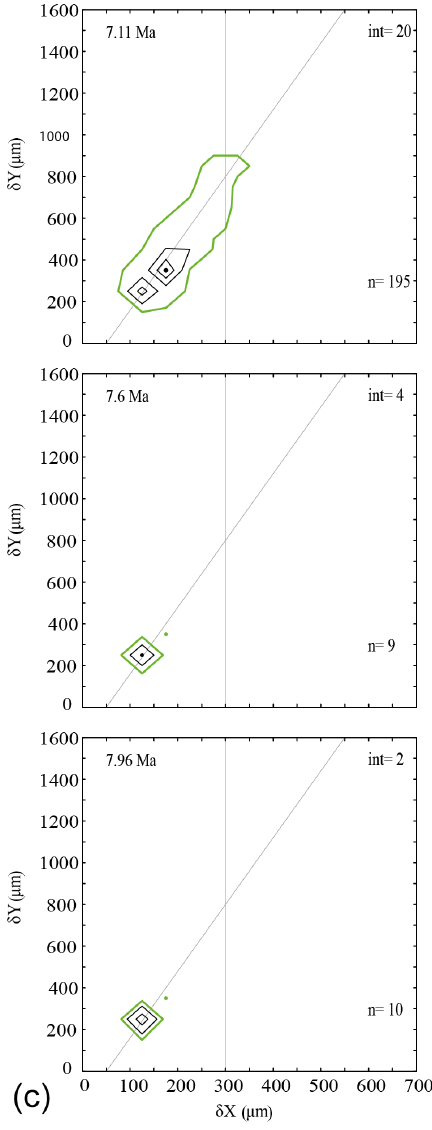
Figure 8. (a, b, c) Contoured frequency plots of spiral height ( δX ) on the x axis versus the axial length ( δY ) on the y axis of Globoro- talia menardii in keel view at ODP 108 Site 667 from 0.003 to 7.96Ma. The upper-left corner shows the age (Ma). “int” indicates the contour interval in the number of specimens per grid cell. The grid-cell size is 50µm × 100µm in direction of δX and δY , re- spectively. “ n ” in the lower-right corner gives the number of speci- mens represented in the diagram. Green-coloured contour lines and dots represent the contour interval from 0 to 1. The diagonal grey line is drawn to separate the morphotype of G. menardii menardii (area below the line) and G. menardii cultrata (area above of the line) proposed by Knappertsbusch (2007a). The vertical grey line at δX = 300µm delimits the dominant population of G. menardii older than 2.88Ma and is also drawn for